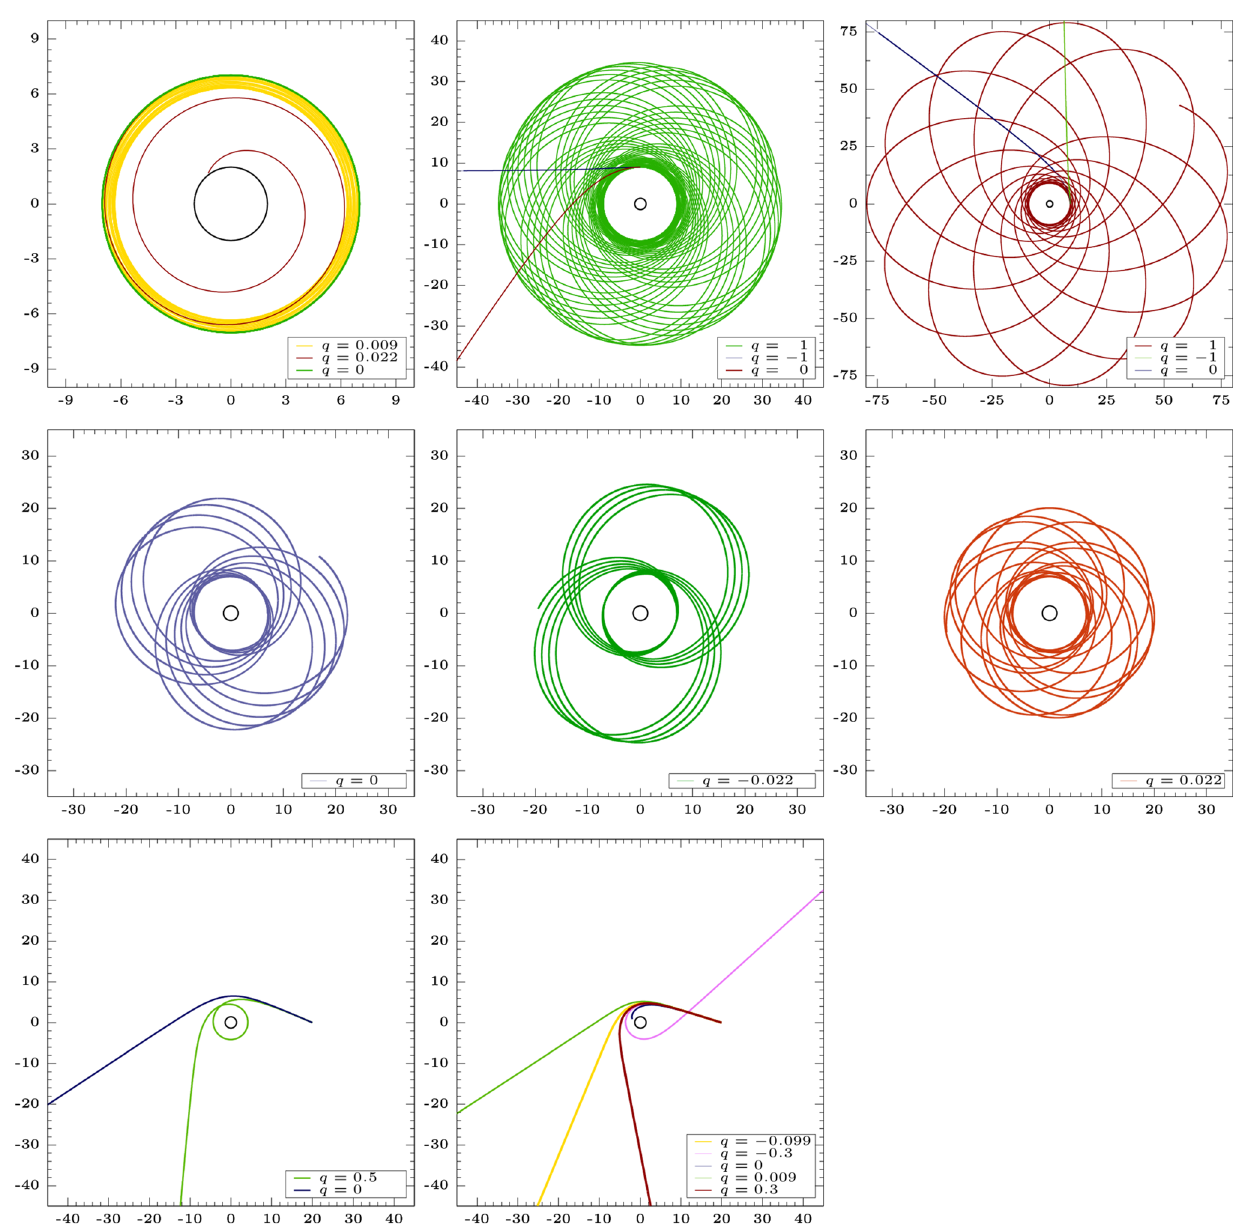
Fig. 14 Time-like geodesics for different values of the quadrupole in the equatorial plane( θ = π/ 2) In the first row, there are unbounded Schwarzschild orbits, with ˙ r = 0. In the second row, there are bounded Schwarzschild orbits with ˙ r = 0. Finally, in the third row, the particles with ˙ r (cid:10)= 0 scape toward